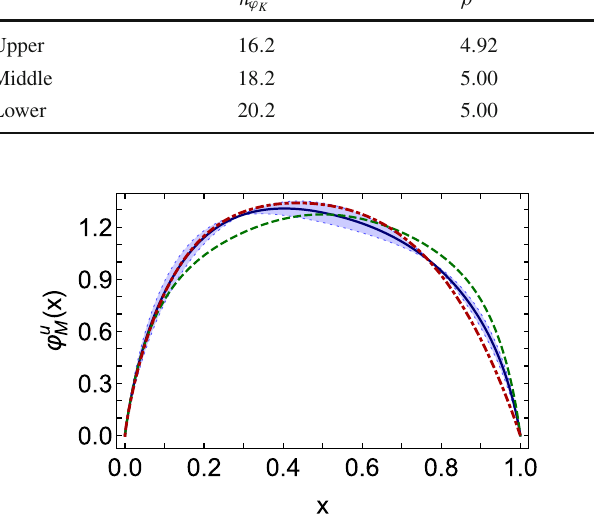
Fig. 8 Acomparisonbetweenkaonandpionvalence-quarkDFs.Solid [ u K ( x ; ζ ) + ¯ s K ( x ; ζ ) ] calculated from Eq.(47). The blue curve: 1 H H 2 associated band marks the domain bounded by the kaon DFs produced using Eqs.(12), (45) and the “upper” and “lower” rows in Table 3. Dashed green curve: u π ( x ; ζ H ) in Eq.(29). Dotted grey curve: scale free form, q sf ( x ; ζ H ) = 30 x 2 ( 1 − x )